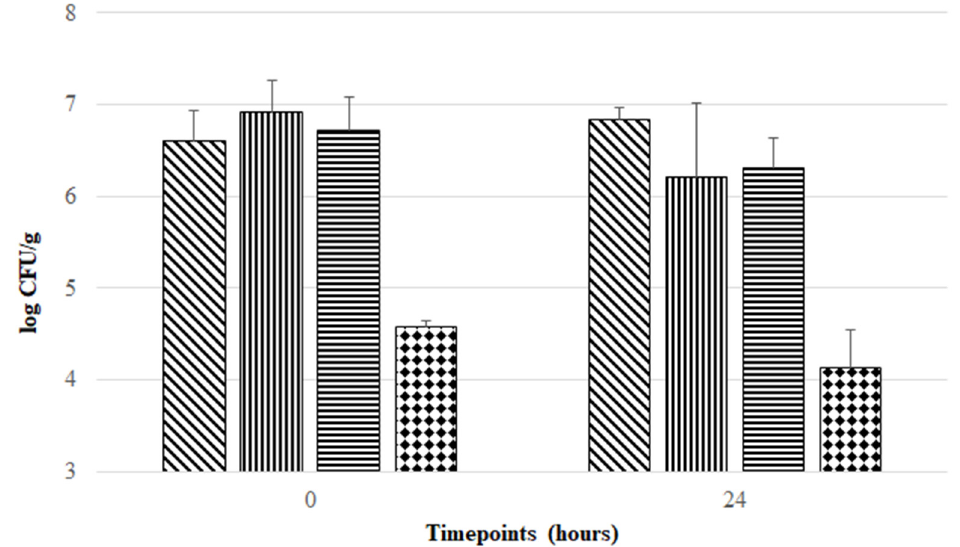
Figure 1. Evolution of viability of F. duncaniae DSM 17677 (mean values in log CFU/g) in different freeze-dried formulations (diagonal lines: ITCR; vertical lines: ISTCR; horizontal lines: ISCR; and diamond pattern: ICR) during aerobic storage at room temperature for 24 h. Error bars represent standard deviation of the mean.